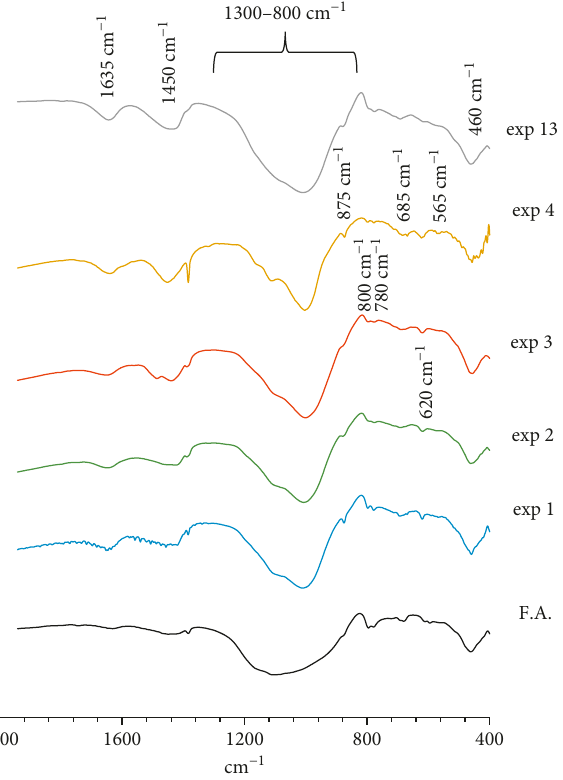
Figure 3: FTIR spectra of the fly ash and Si foamed